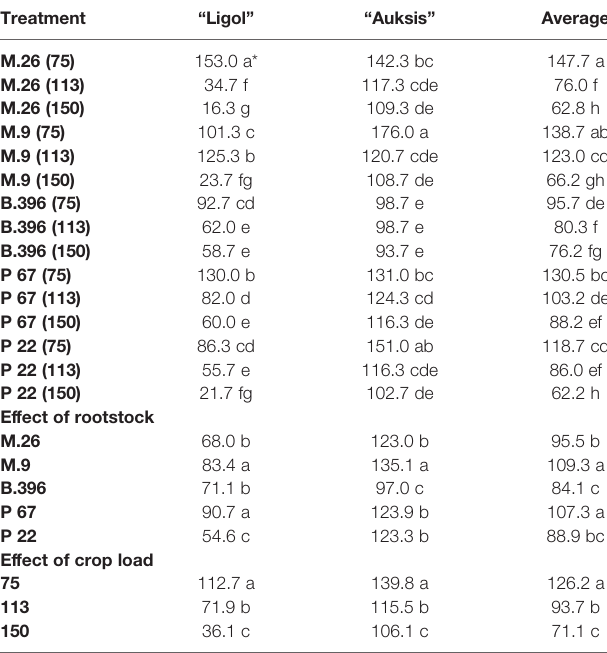
TABLE 1 | The effect of rootstock and crop load interaction on the return bloom of “ Ligol ” and “ Auksis ” apple trees (number of fl ower clusters tree − 1 ). Treatment